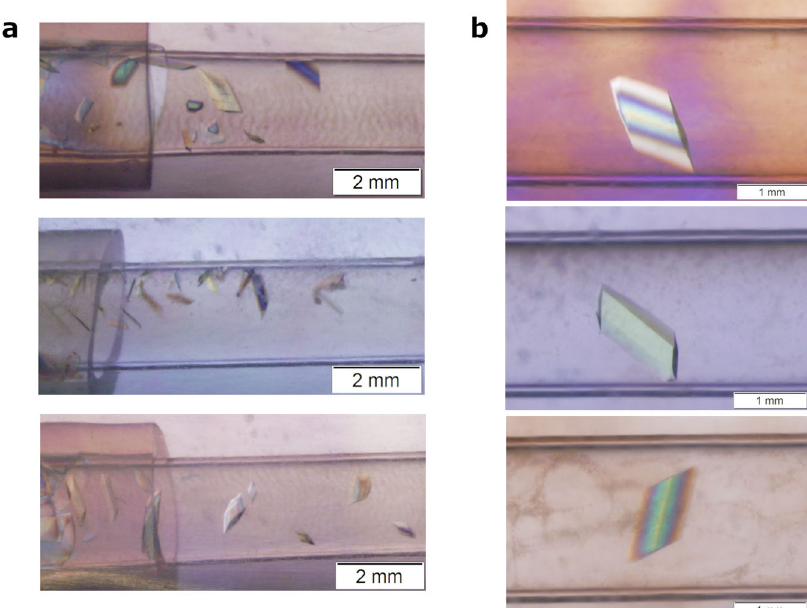
Fig. 3 Perdeuterated TS crystals from micro- and unit gravity PCG-15 experiments. The crystals were visually assessed and imaged at Oak Ridge National Laboratory following their retrieval from Johnson Space Center after CRS-18 capsule splashdown. a Representative pictures of larger ground control pD-TS crystals grown in TCB capillaries with 2 mm scale bar. The crystals grew near the bottom of the capillary and were relatively small with some inclusion defects. b Representative pictures of larger microgravity-grown pD-TS crystals from TCB capillaries with 1 mm scale bar. Flight crystals were single and large, nearly spanning the width of the capillary (2